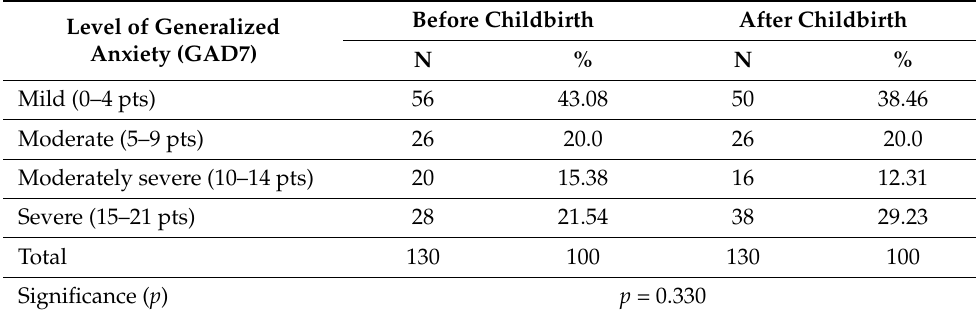
Table 3. Level of prenatal and postnatal anxiety in the study group.